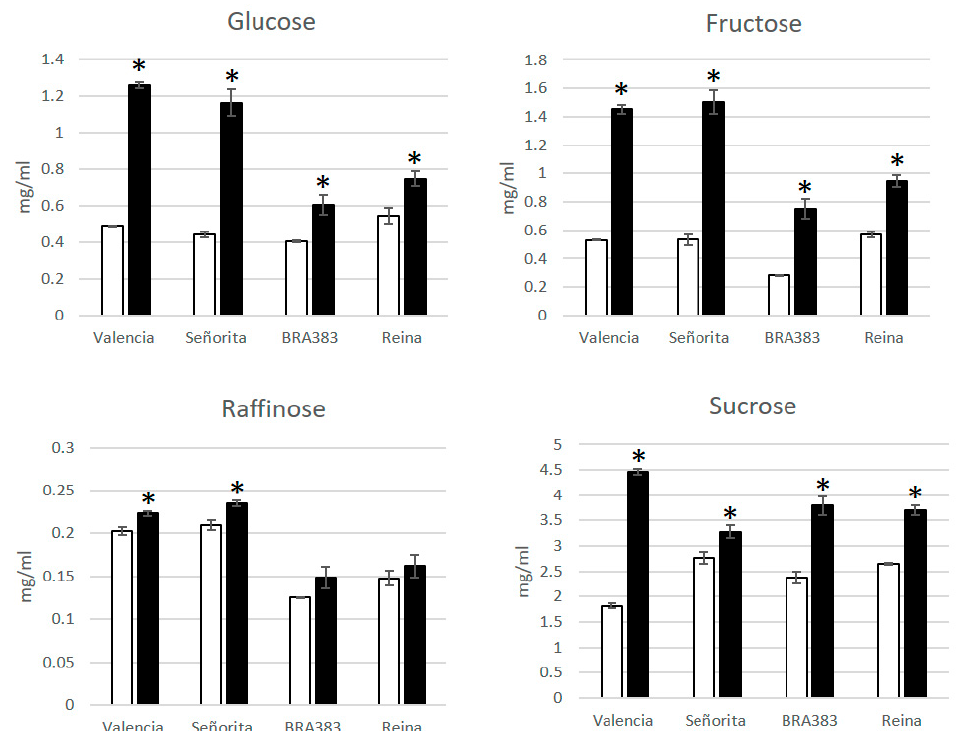
Figure 4. Sugar content in four different genotypes from Costa Rica (Valencia and Señorita) and Colombia (Bra383 and Reina). Dry matter was expressed as the percentage of dry weight relative to fresh weight. Sugar (and organic acids) analysis was carried out from a 500 mg flour sample. Two determinations were carried out with each flour sample. Sugars were analyzed using HPLC (Agilent Technologies 1200 series, Waldbronn, Germany). Samples were separated isocratically at 0.6 mL/min and at 30 °C and retention times and standard curves were prepared for glucose (Sigma-Aldrich, St. Louis, MO, USA, G7528), fructose (Sigma-Aldrich F2543), and saccharose (Sigma-Aldrich; ≥ 99.5%; S7903). P -values < 0.05 (*) were considered as significant. Error bars are the mean +/- SEM (standard error of the mean).